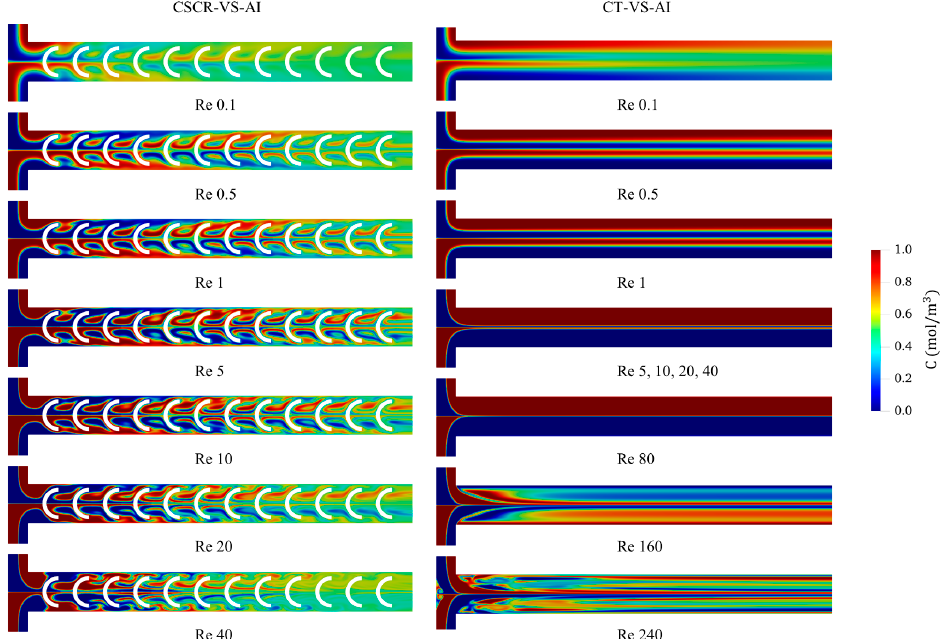
Figure 15. Concentration distributions on the x - y plane at z = 50 µ m in CSCR-VS-AI ( left ) and CT-VS-AI ( right ) micromixer configurations for the Re scenarios simulated ( D = D 1 ). All planes are normal to the z -direction. In each plane, y -direction is shown between y = + 200 µm and y = − 200 µm.